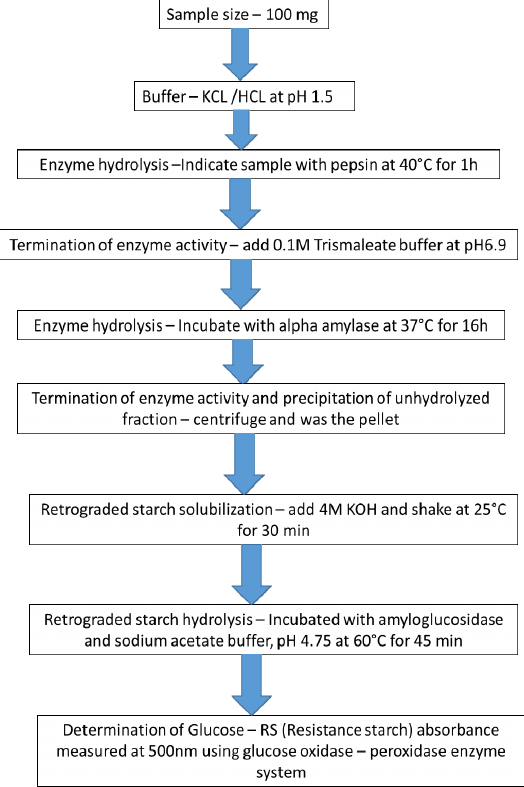
Figure 3. The procedure used by Goñi et al. [36] and Perera [37] for the determination of resistant starch (RS) in food. Copyright obtained from Perera et al. [37].